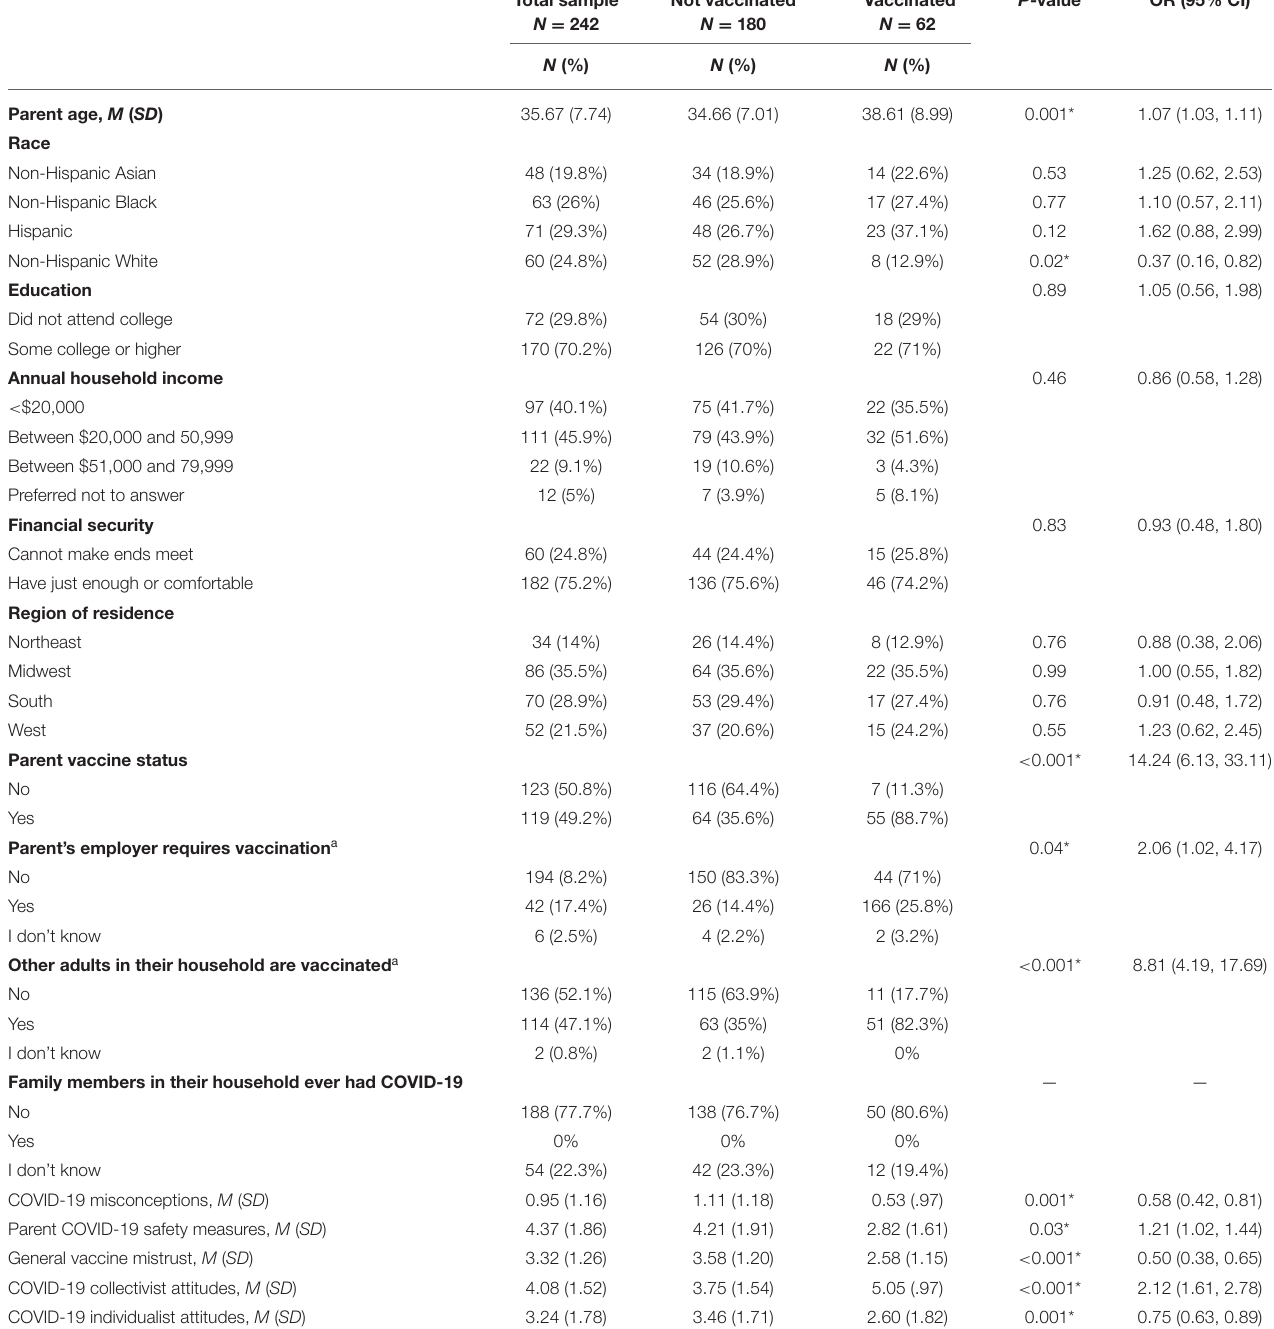
TABLE 1 | Frequencies/percentages and means/standard deviations for parental demographic characteristics and COVID-19 related beliefs and attitudes and unadjusted bivariate analyses predicting adolescent vaccine status for the full